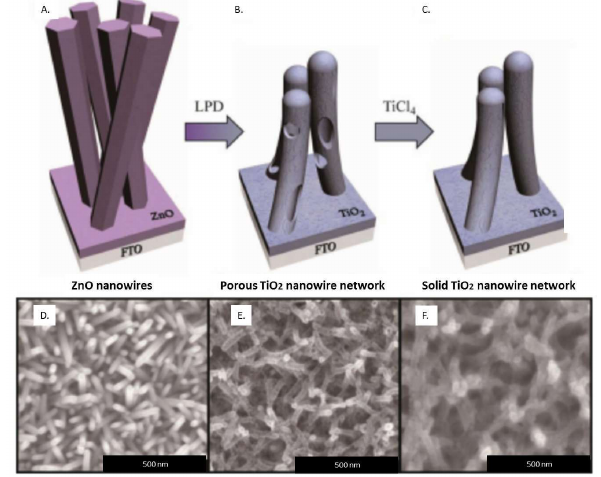
Fig. 3. Fabrication procedure for TiO 2 nanowire network electrodes for CQD BH solar cells. (A, D) ZnO nanowires were first